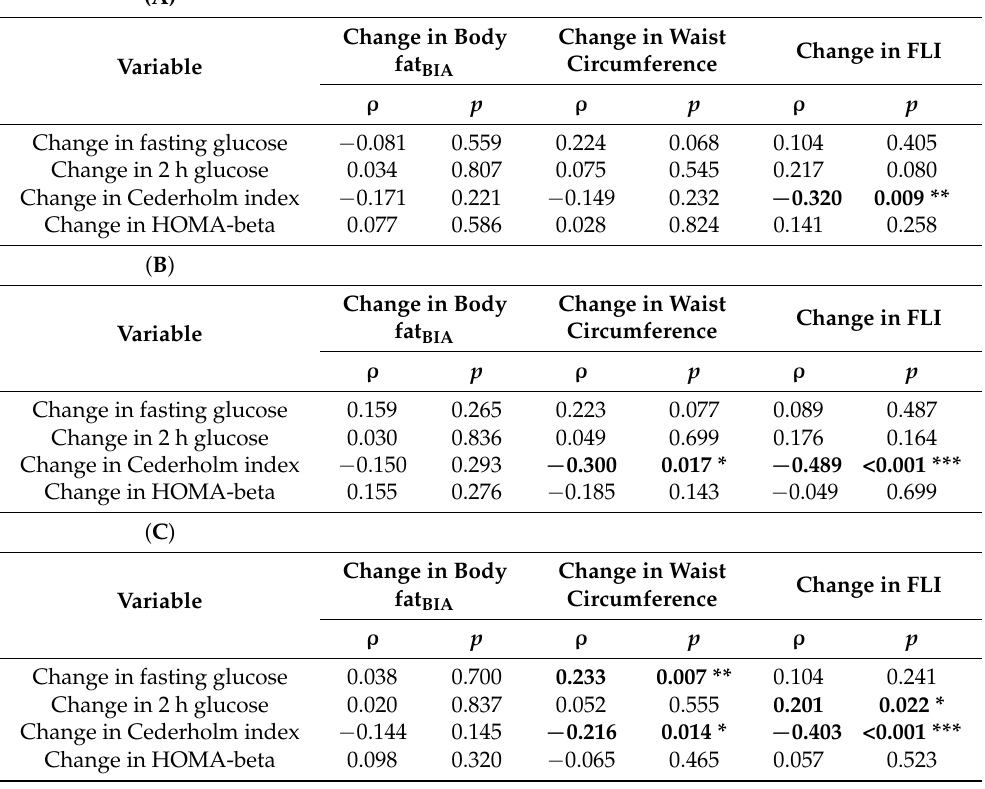
Table 3. Correlation of fold changes in body fat compartments and metabolic outcomes; ( A ): placebo group, ( B ): fiber group; ( C ): total cohort; Spearman correlations. Significant results are printed